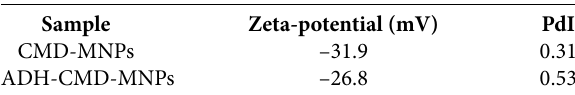
Table 4. Zeta-potential and PdI obtained by DLS analysis of CMD- MNPs and ADH-CMD-MNPs. Sample